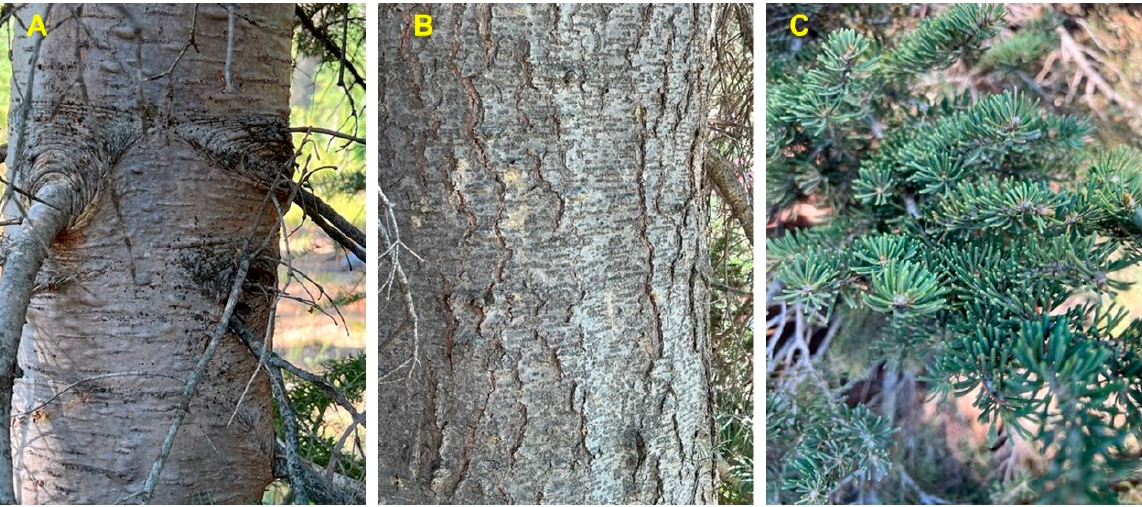
Figure 2. Abies lasiocarpa var. lasiocarpa from southern Idaho. ( A ): bark of young tree. ( B ): bark of old tree. ( C ): foliage. Photographs by K. Swor.